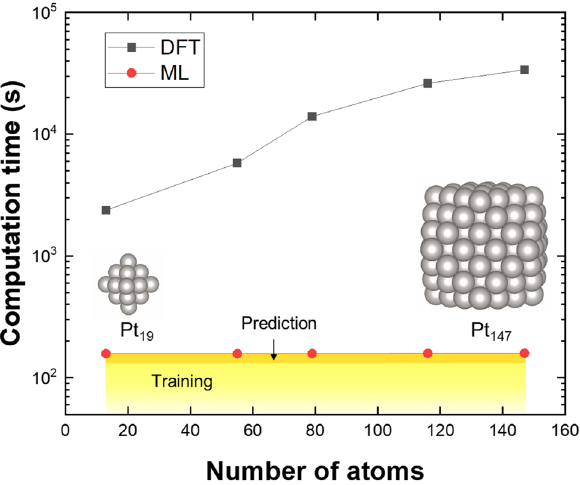
Figure 6. Computational cost of of PCA-CGCNN methods. Comparison of the computation time for calculations of DOS patterns of metallic NPs via DFT (black) and ML (red). For the DFT calculations, a 2.3 GHz 20 core CPU was used. For the PCA-CGCNN methods, a personal computer with a GTX 2070 GPU and i5-9600 K CPU was used, and the computational times were measured as a sum of training and prediction